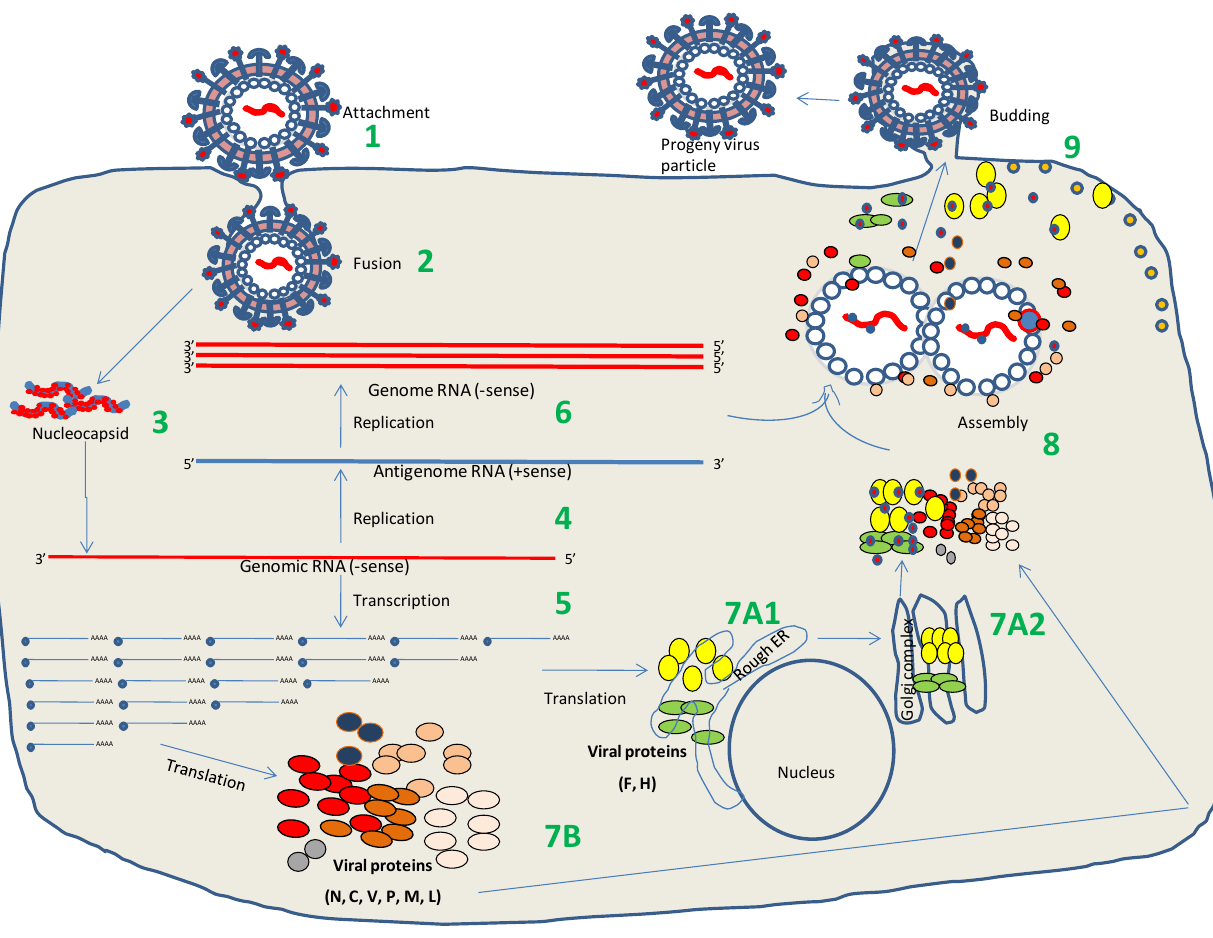
Figure 2. PPRV life cycle. (1). Attachment of the virus to host cell receptors (SLAM/Nectin-4) via its HN protein. (2). Fusion with plasma membrane via the F and HN proteins (3). Release of the viral genome into cytoplasm. (4). Genome replication by the virus-encoded RdRp of the RNPs (5). mRNA synthesis by the virus-encoded RdRp in the ‘start-stop’ mode (a mechanism of controlling the amount of individual protein being produced). (6). Synthesis of full-length positive sense RNA (antigenome RNA or complementary RNA, cRNA). (7). Synthesis of viral proteins: F and H proteins are synthesized on RER (7A1) and translocate across Golgi complex (7A2), where post-translational modifications take place. Other viral proteins (N, P, C, V, M, L) are synthesized on ribosomes (7B). (8). Assembly of progeny virions. (9). Budding of the progeny virions at the plasma